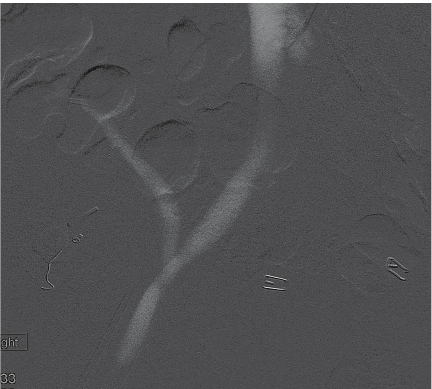
Figure 2: CO 2 angiogram obtained after placement of stent in renal transplant vein showed no residual